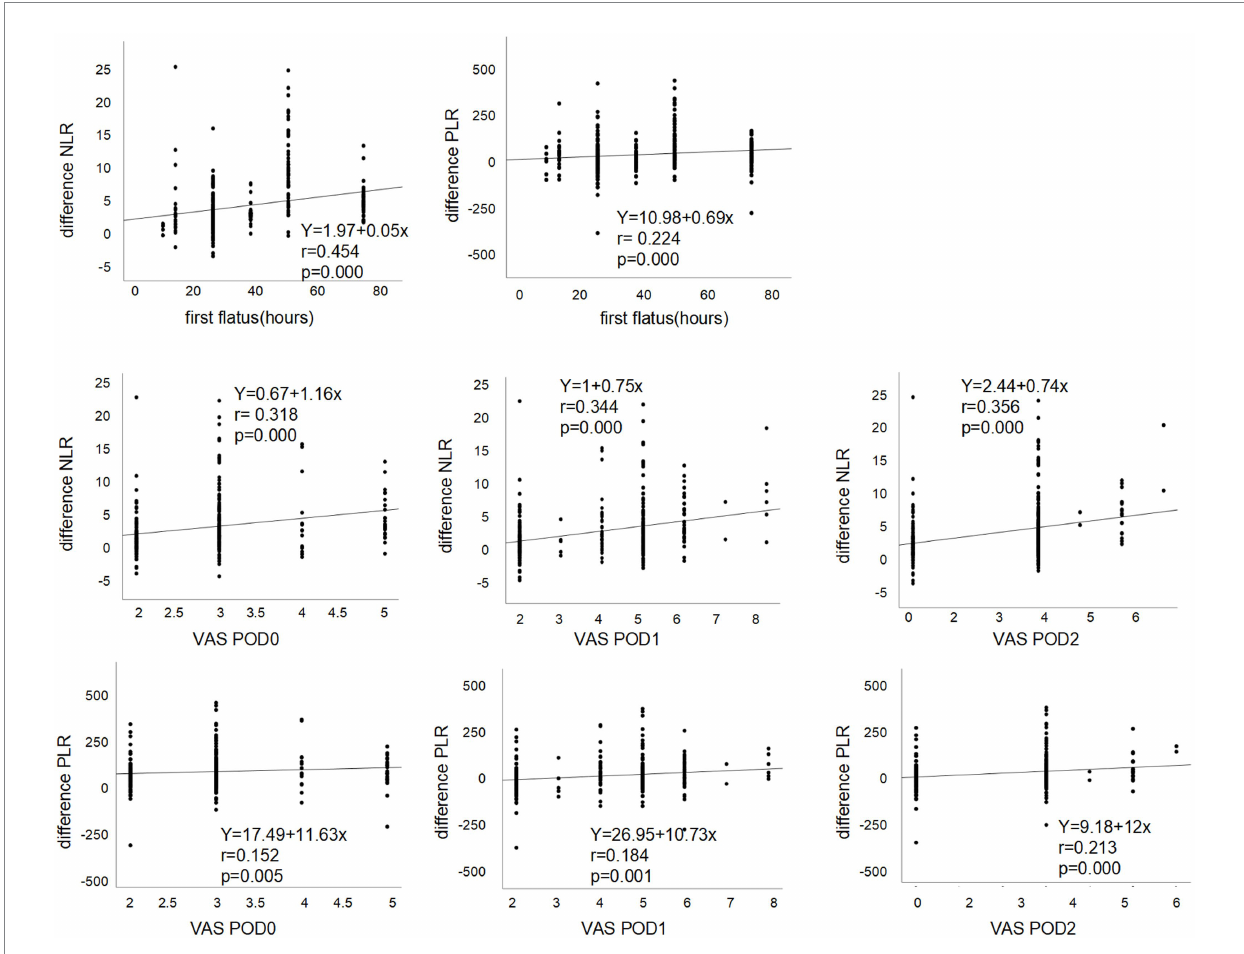
FIGURE 4 Linear regression and scatter diagram between first flatus time postoperatively, VAS score in POD0, POD1, and POD2 of patients following gynecologic surgery and the perioperative difference between neutrophil-to-lymphocyte ratio (NLR) and platelet-to-lymphocyte ratio (PLR).